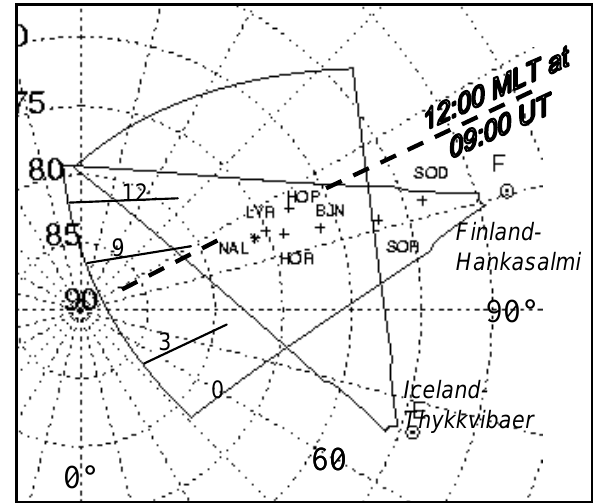
Fig. 2. Geometry of the fields of view of the CUTLASS radars at Thykkvibaer (E) and Hankasalmi (F) in AACGM coordinates. The directions of the beams of the Hankasalmi radar displayed in Fig. 5 are indicated. The position of the magnetometer stations is also indicated. The thick dashed line shows the 12:00MLT meridian at